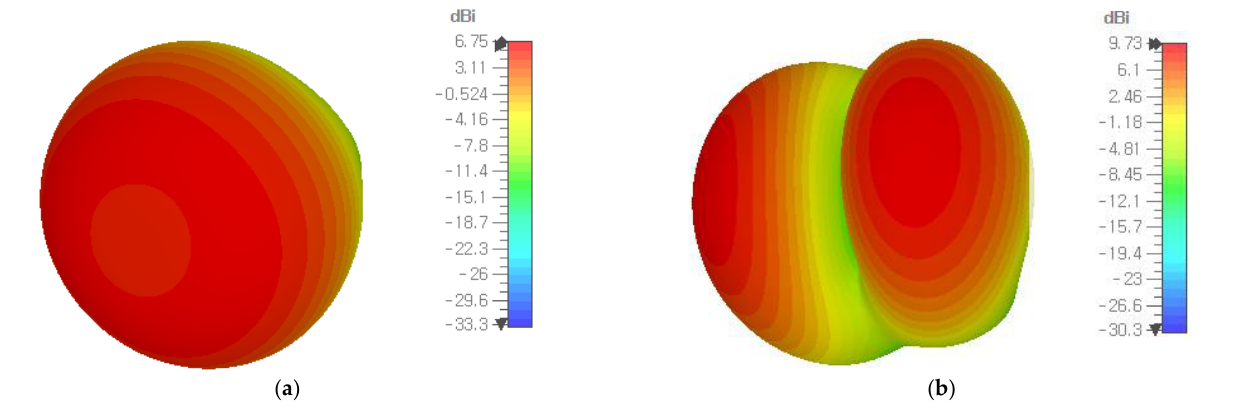
Figure 12. 3D directivity patterns of the feed at 14.5 GHz. ( a ) Sum channel. ( b ) Azimuth difference channel. Arrows mark the maximum and minimum values of the directivity.